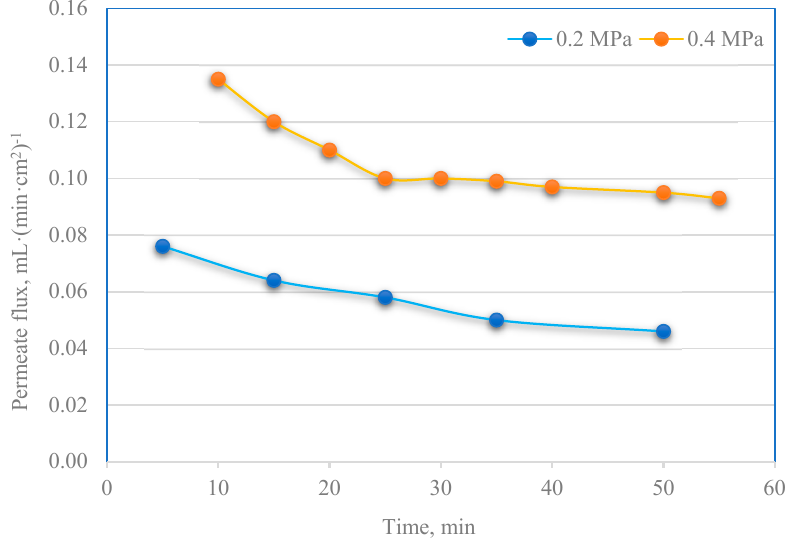
Figure 5. PPW permeate flux vs. time for processes conducted under 0.2 and 0.4 MPa of transmem- brane pressure.